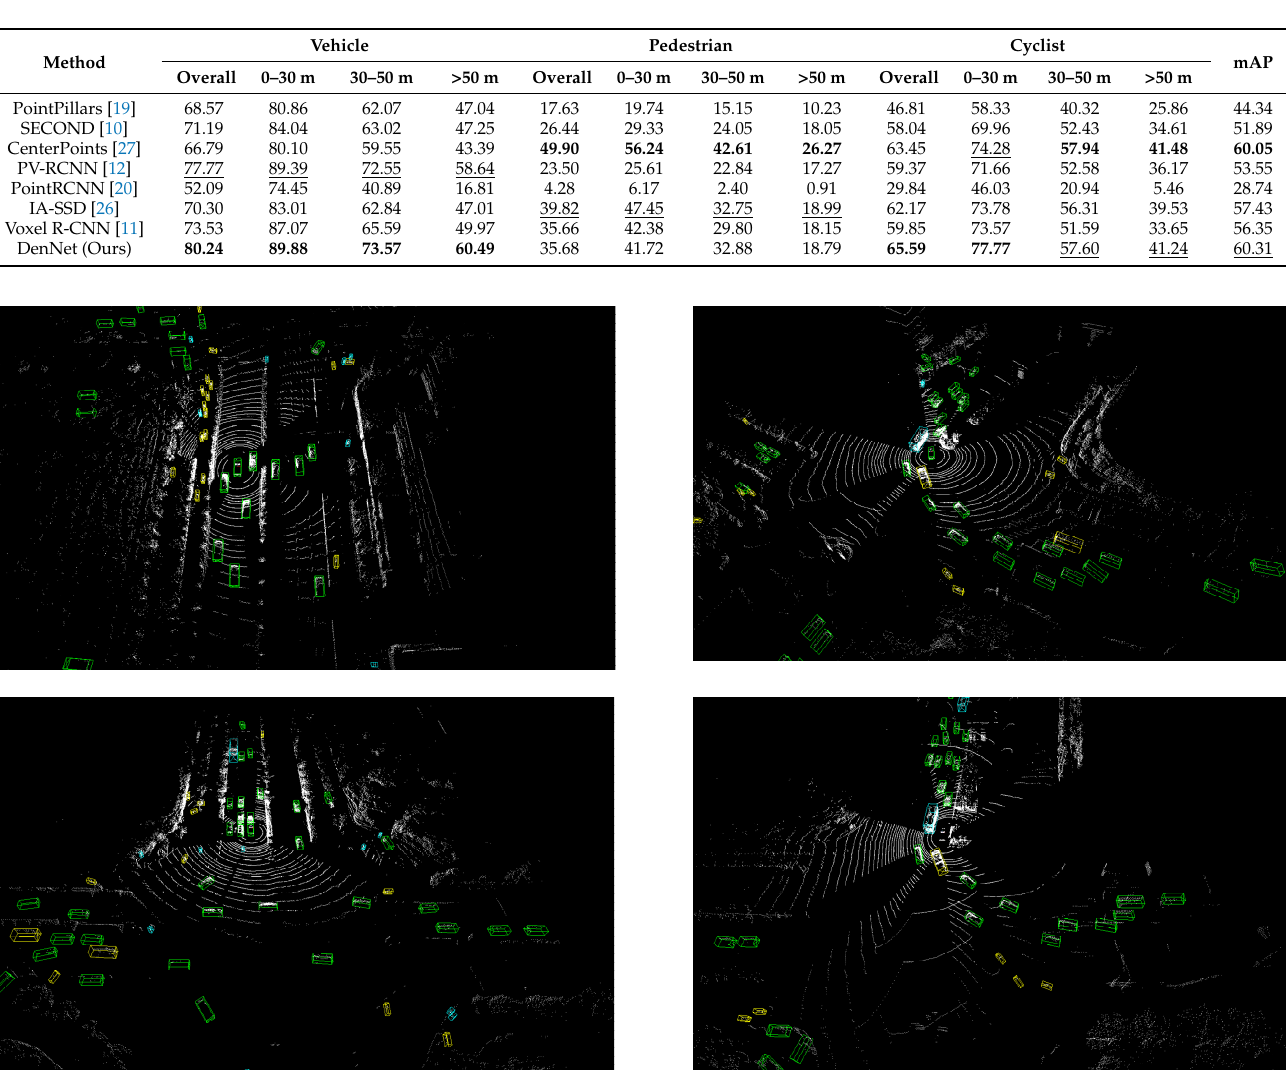
Figure 8. Qualitative results achieved on ONCE dataset. Boxes denote the prediction results.